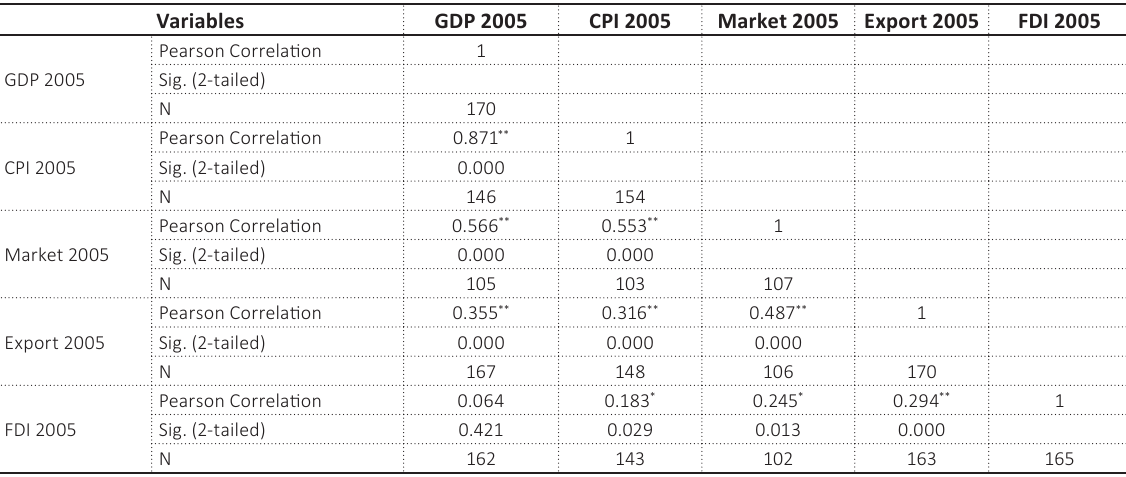
Table 6. Pearson correlation matrix for each of the five variables for 2005